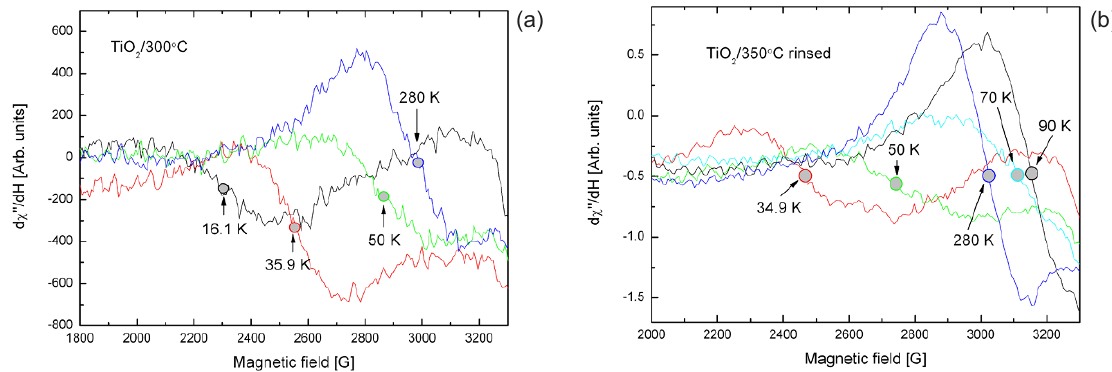
Figure 8. EPR spectra of broad component in samples [TiO shift of the resonance